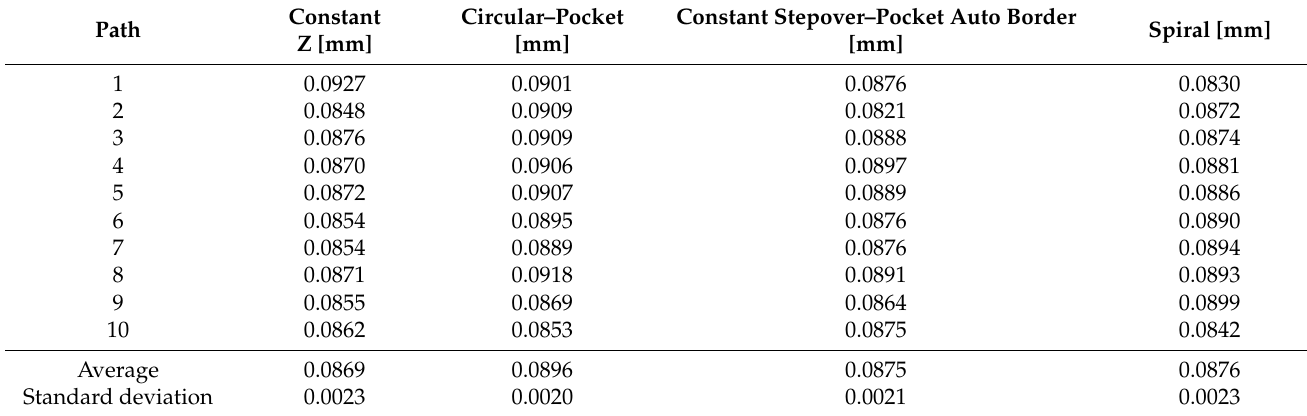
Figure 13. Roundness deviations ( a ) constant step over – pocket auto border strategies; ( b ) spiral strategy. The roundness values for the single measured circular paths are shown in Table 3. deviations in shape. Table 3. Measured roundness deviations. Table 3. Measured roundness deviations.